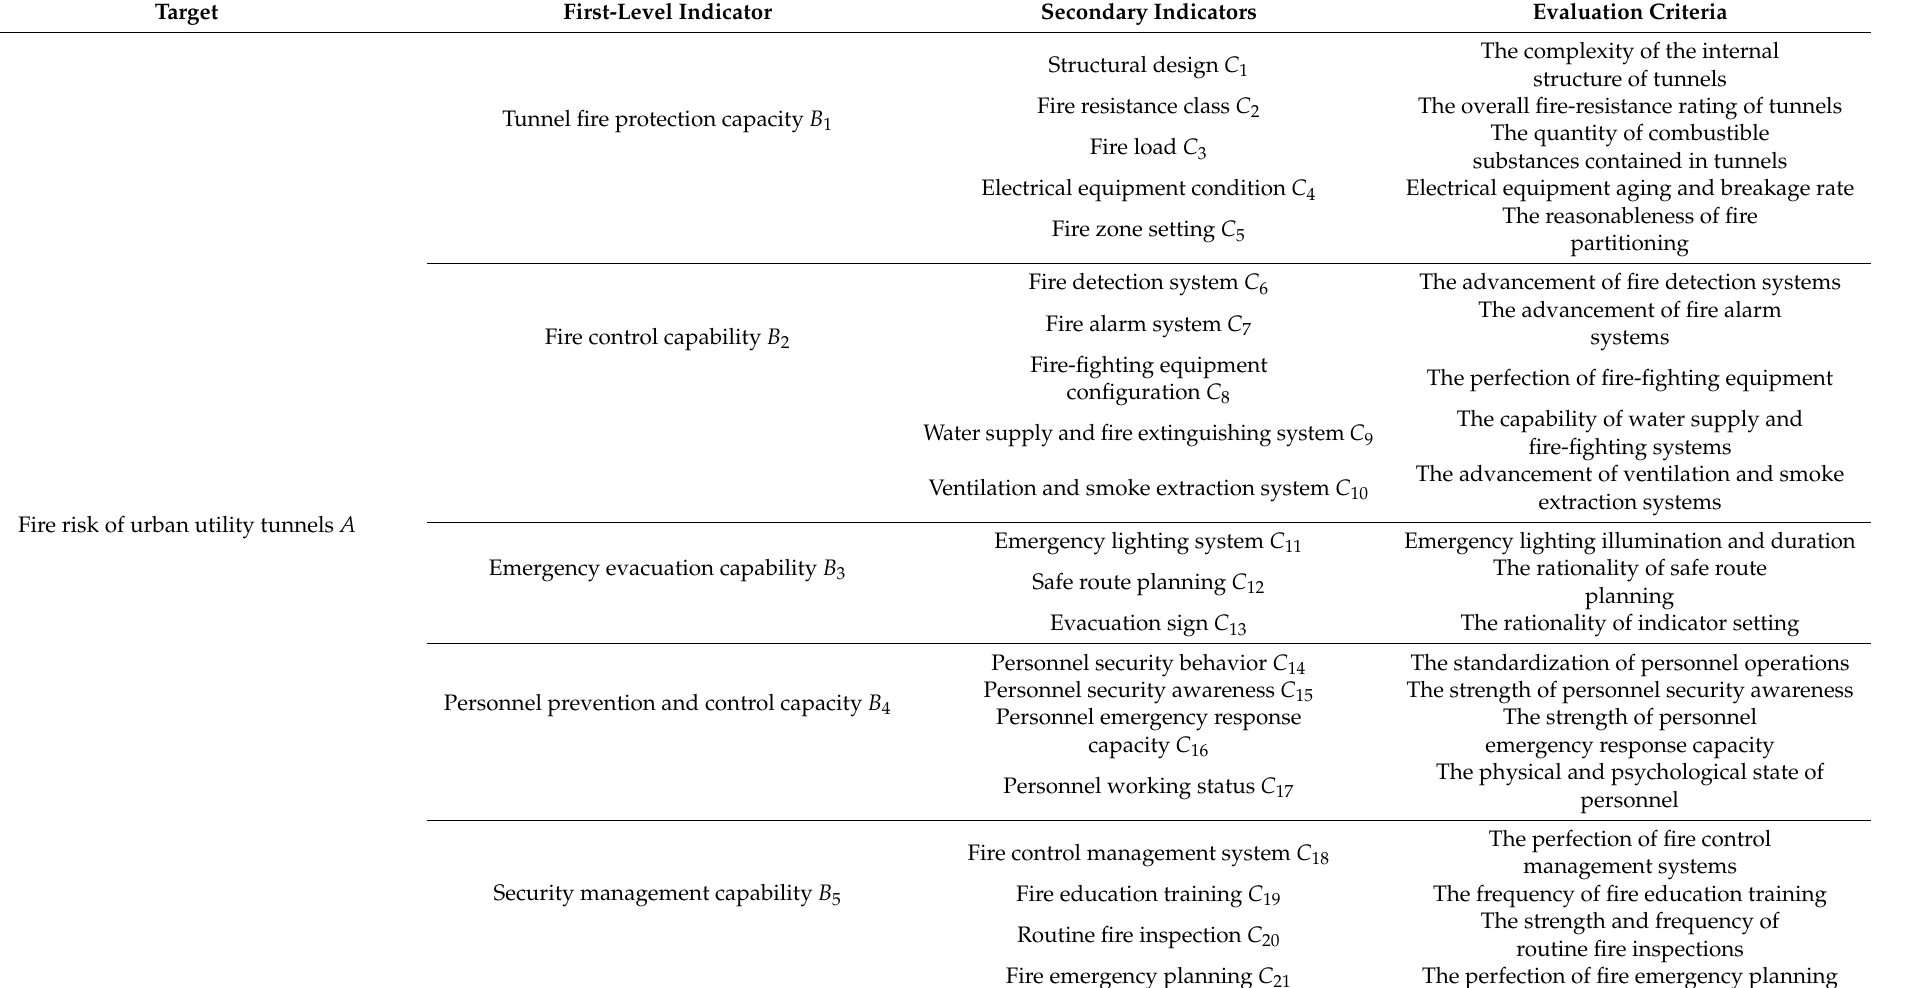
Table 1. Evaluation index system for urban utility tunnels’ fire